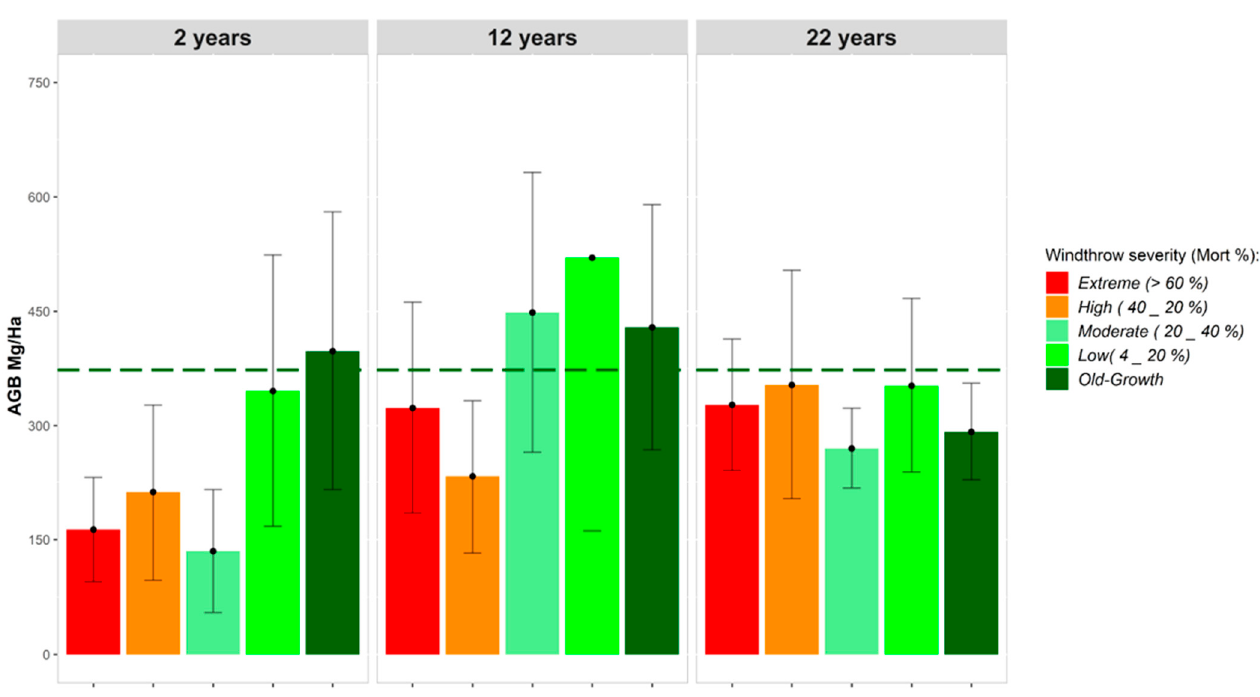
Figure A1. AGB estimations for model 1 (Chave et al, 2014) and model 2 (Magnabosco Marra et al., 2016) at circles and triangles, respectively. Red and Blue lines show the regression using Generalized additive model (GAM) for both models.